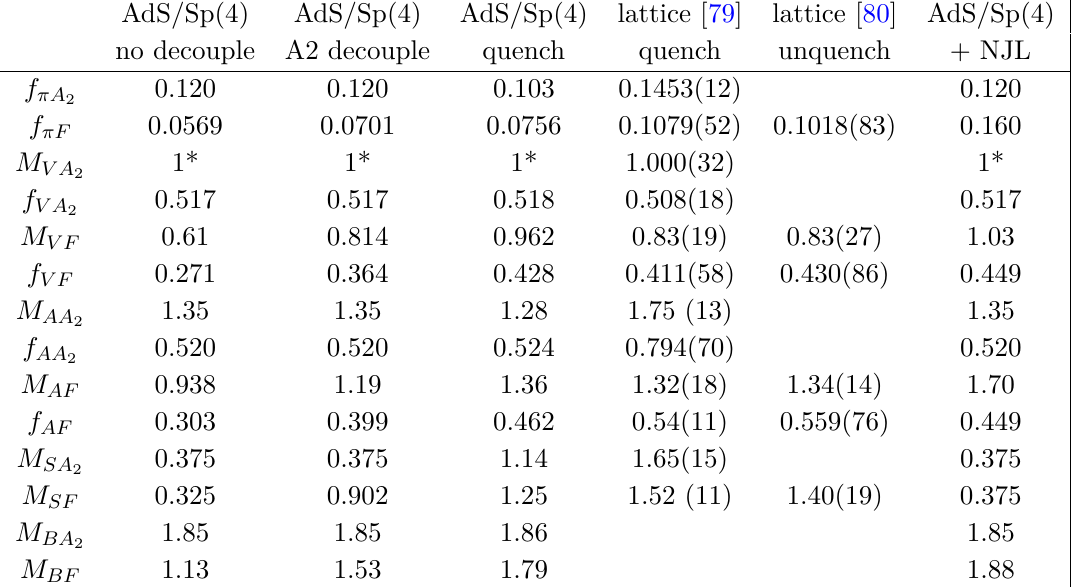
Table 4. AdS/ Sp(4) 4 F, 6 A 2 . Ground state spectra and decay constants for our various